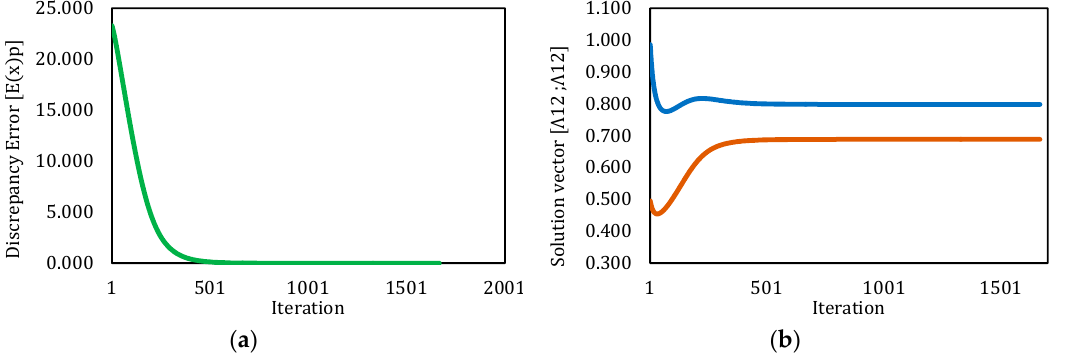
Figure 10. Behavior of discrepancy error and solution vector for Levenberg–Marquardt method-simulation 3. ( a ) Behavior of discrepancy error respect to iterations. ( b ) Behavior of values for solution vector respect to iterations.